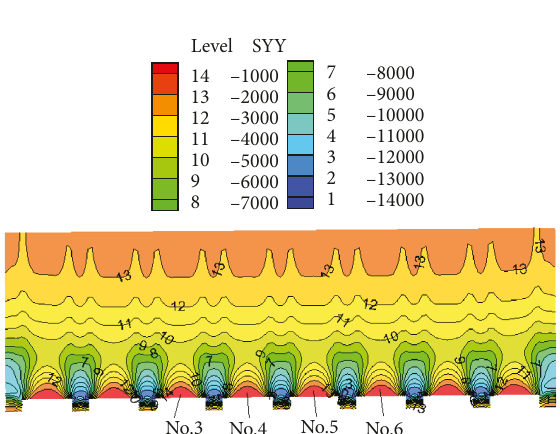
Figure 6: Principal stress isoline map in the Y